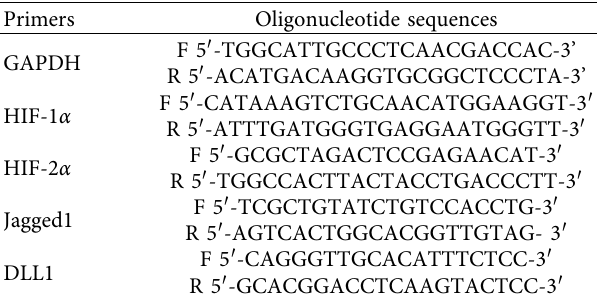
Table 1: Primers used in real-time PCR experiments.